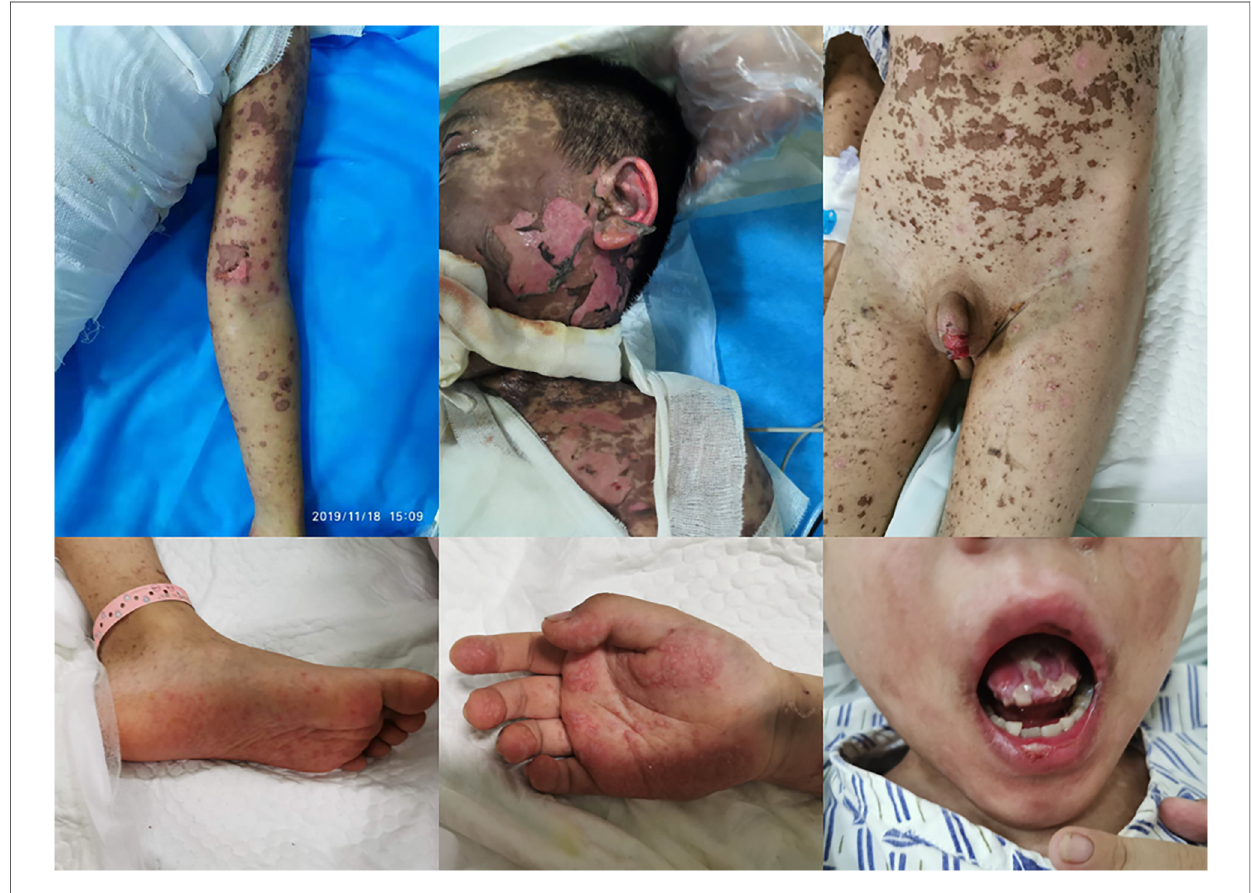
FIGURE 1 Rashes and blistering in different parts of the